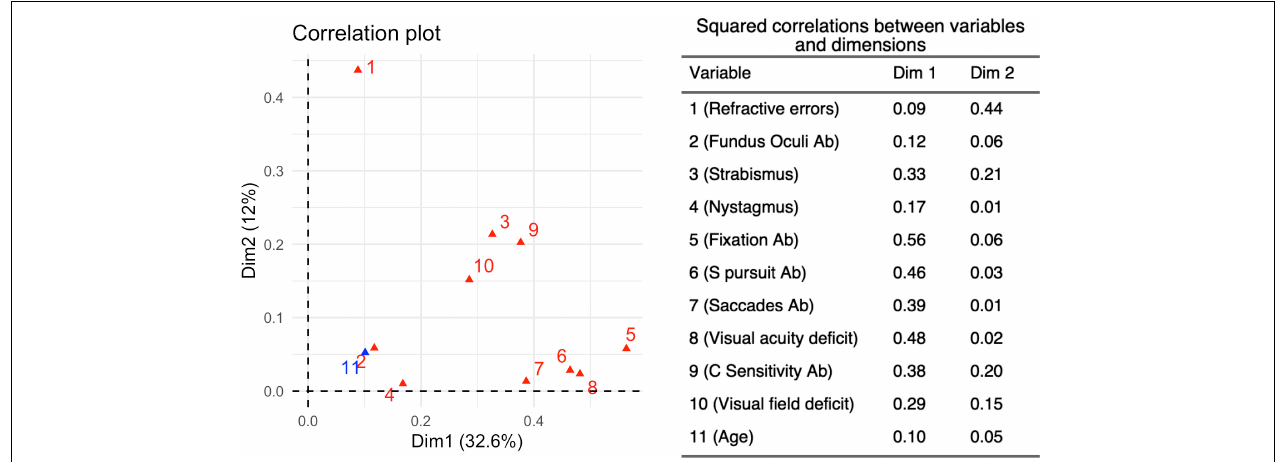
FIGURE 8 | Squared Correlations (r 2 ) between each variable and the first two main Dimensions 1 and 2. The r 2 -values related to the two dimensions determined by the MCA for 10 variables, identified from the neurovisual evaluation carried out in 180 children belonging to the three different age subgroups. Dimension 1 accounts for 32.6% of the variance in this analysis, while Dimension 2 accounts for 12%.